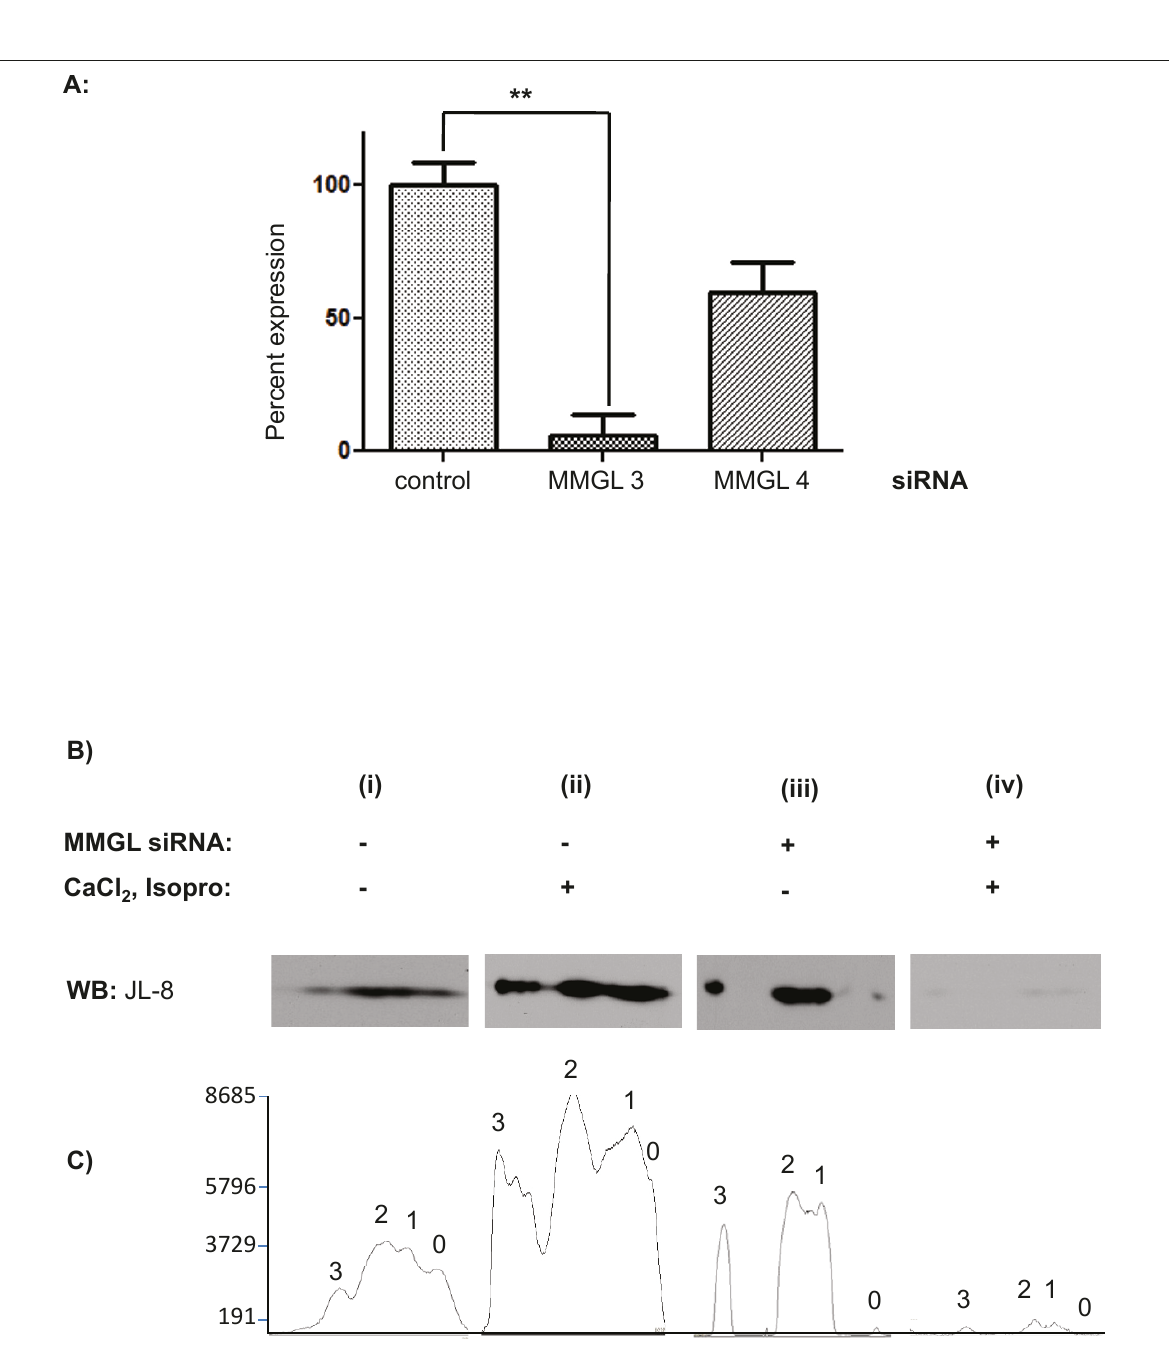
Figure 7 siRNA-mediated knockdown of MMGL leads to reduced levels of cMyBPC phosphorylation under adrenergic stimulation . A . Graph demonstrating that real-time quantification of MMGL cDNA transcribed from RNA extracted from cells transfected with either a non- silencing control or a particular MMGL siRNA. Pde4dip Rn_RGD:708410_3_HP (MMGL 3) resulted in optimal knockdown of MMGL (80%). B . Western blots of 2-dimensional IEF gels showing the expression of the four phosphorylation isoforms of GFP-cMyBPC in H9C2 cells (i) under non-stimulated conditions; (ii) under adrenergic stimulation, (iii) under non-stimulated conditions in the absence of MMGL (i.e. with MMGL knock-down) and (iv) under adrenergic stimulation in the absence of MMGL. C . Quantification of cMyBPC isoforms in the autoradiographs of the 2-dimensional IEF gels shown in (B), graphing the levels of the four phosphorylation isoforms (0 = unphosphorylated; 1 = monophosphorylated, 2 = diphosphorylated, 3 = trisphosphorylated). B and C(i) show that under non-stimulated conditions, levels of the mono- and diphosphorylated forms are similar and increased compared to the trisphosphorylated form. B and C(ii) show that under adrenergic stimulation, there is a relative increase in the trisphosphorylated form of cMyBPC and reduction of the non-phosphorylated form. B and C (iii) show that under non-stimulated conditions, ratios of the four forms of cMyBPC are similar to that in wild-type cells. B and C(iv) show that, upon adrenergic stress, knock-down of MMGL leads to a reduction in the levels of all cMyBPC phosphorylation forms. Abbreviations: JL8 = antibody directed against